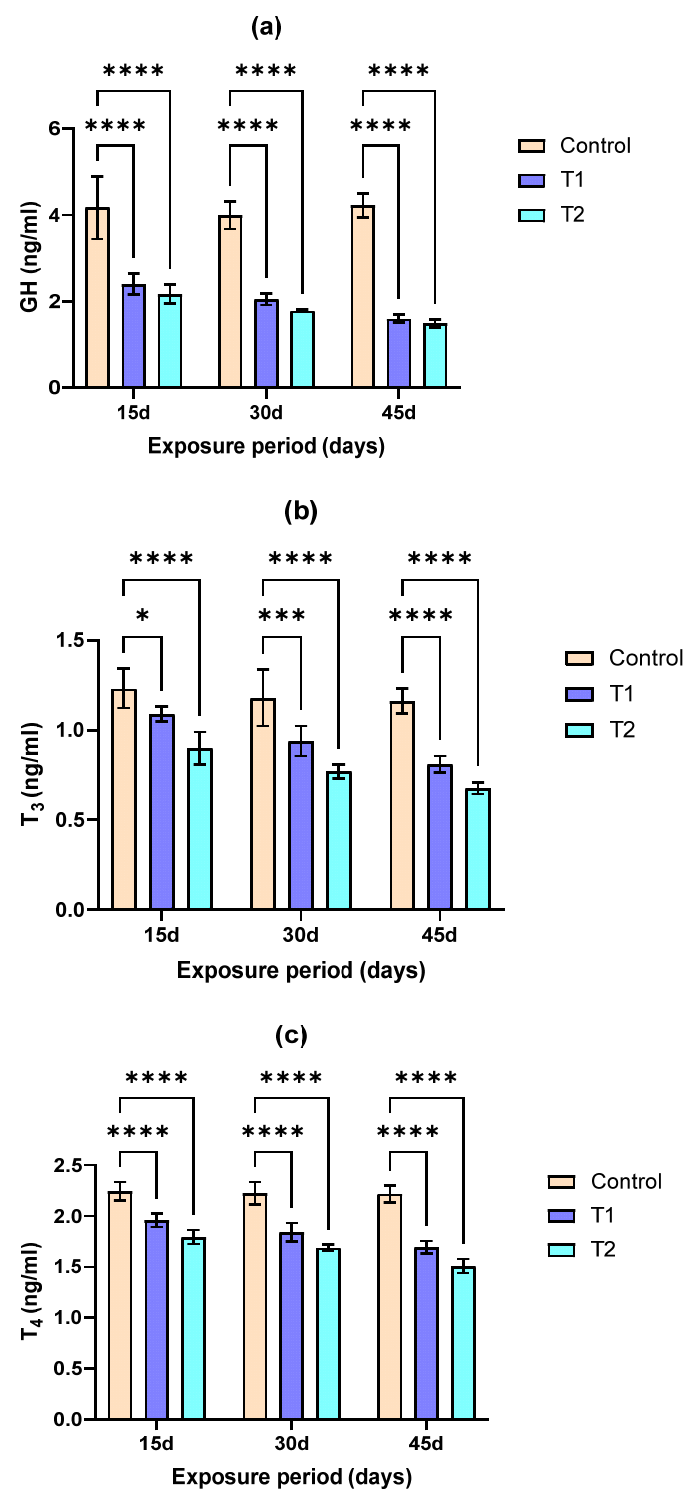
Figure 3. ( a – c ) Mean and SD values of different hormones of Clarias batrachus exposed to different concentrations of diazinon (0.64 and 1.28 mg/L) for different exposure times (15, 30, and 45 days). *—denotes significant differences to control within the same exposure time (* p < 0.05, *** p < 0.001 and **** p < 0.0001); GH—G=growth hormone, T 3 —tri-iodothyronine, T 4 —tetra-iodothyronine (thyroxine).